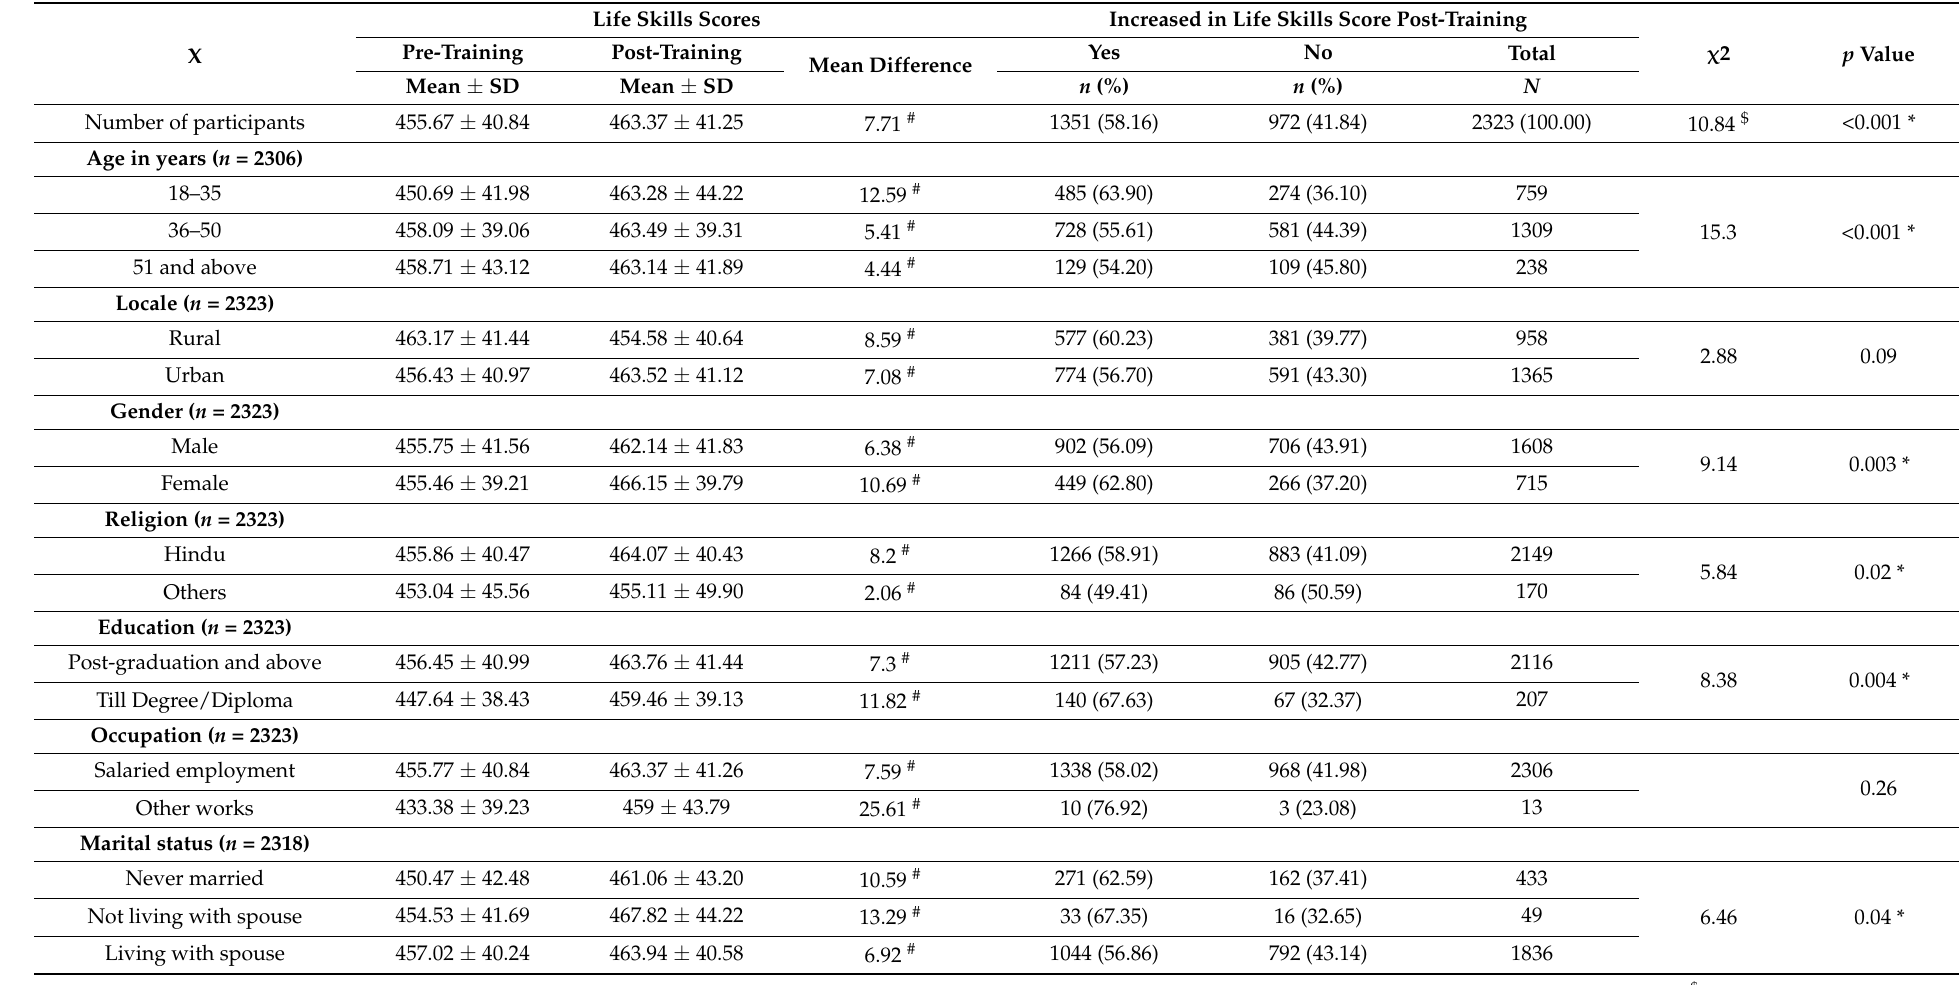
Table 2. Life skill scores (pre–post training) and participants with increased life skills score post-training by select socio-demographic